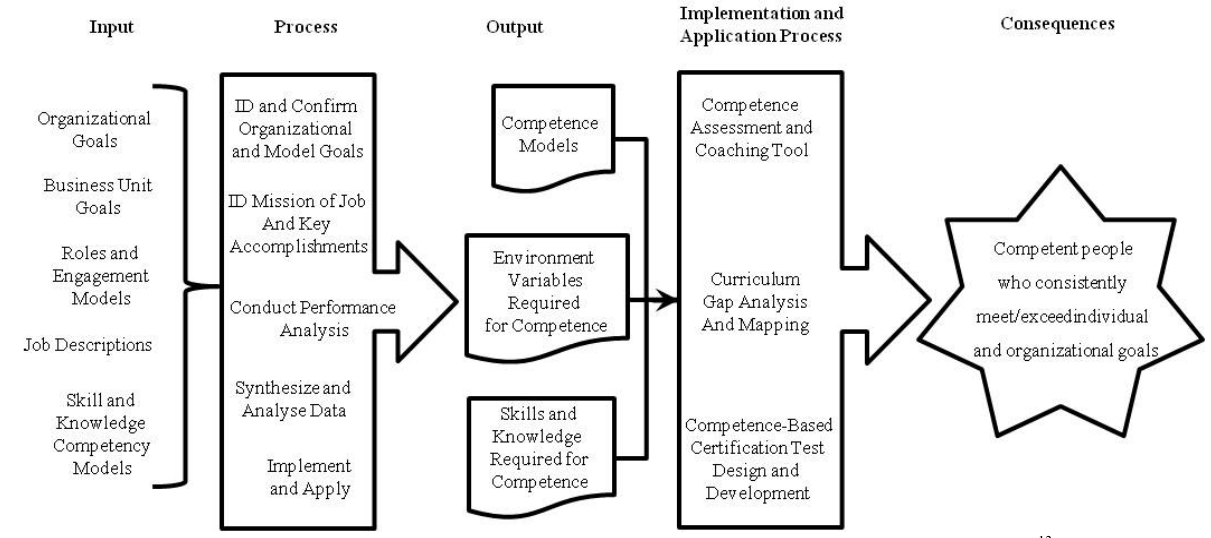
Teodorescu and Binder’s Components and Processes for Building a Competence Model